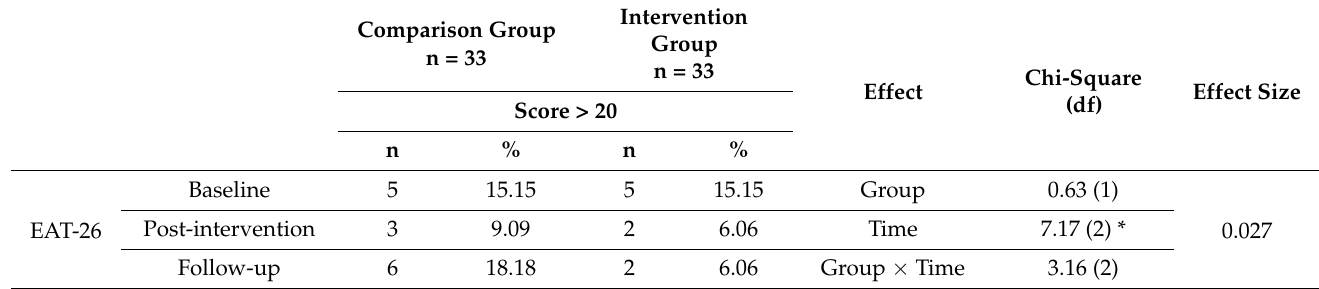
Table 7. Differences between the number of participants with eating disorders